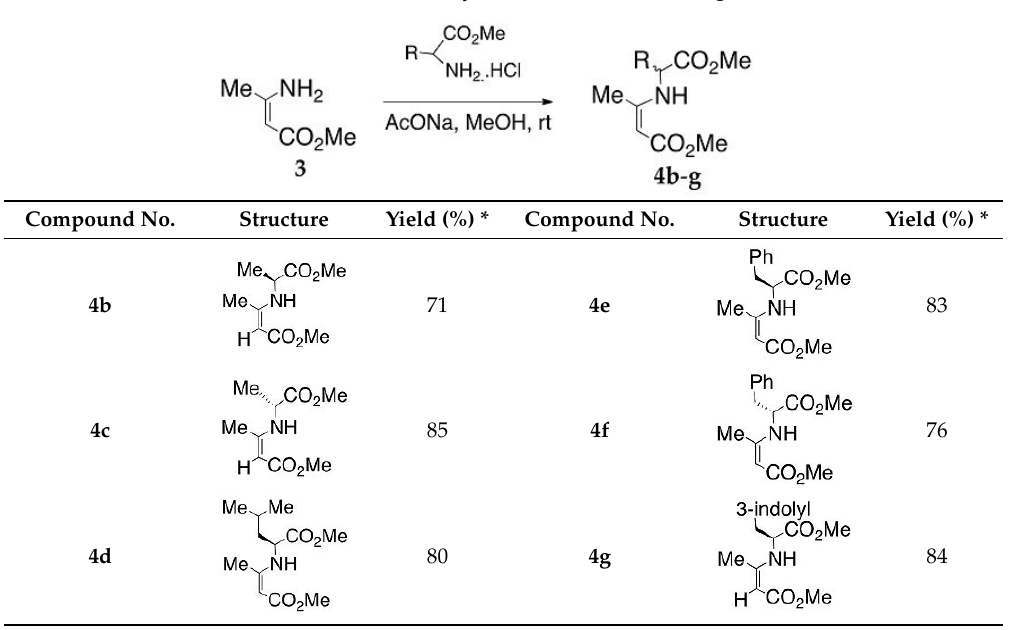
Table 1. Structure and yields of enaminones 4b – g